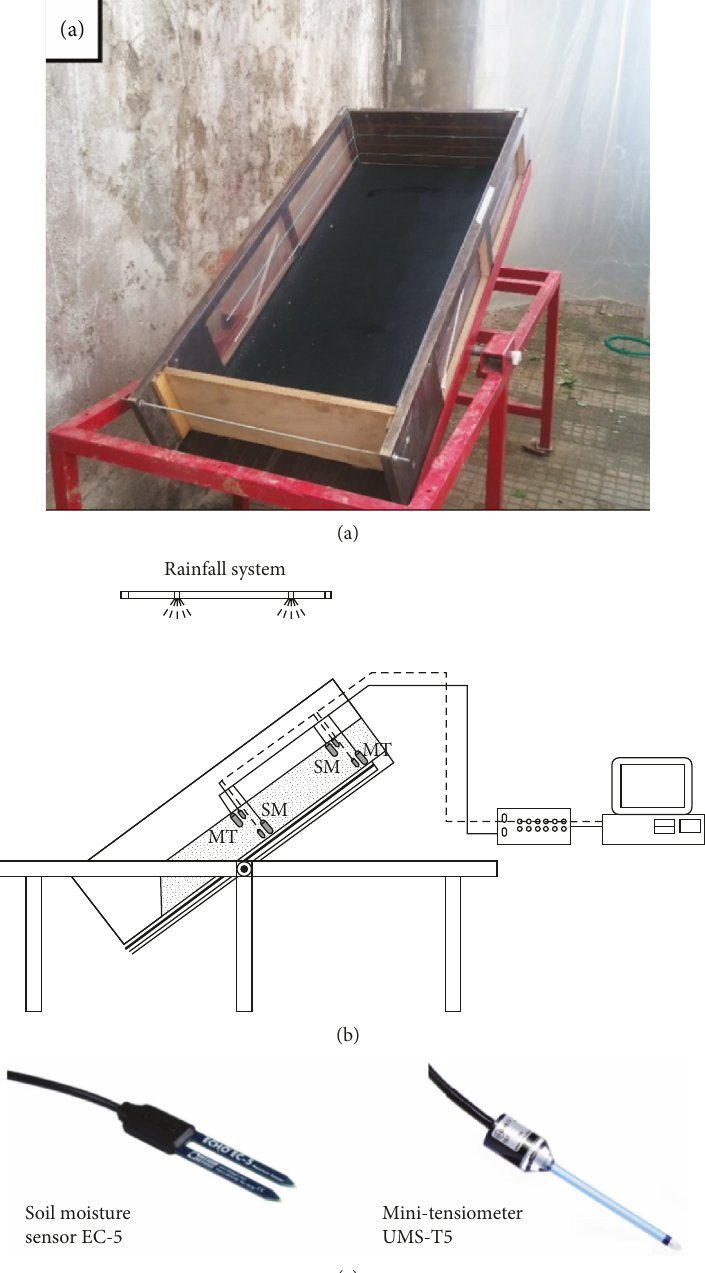
Figure 4: (a) The experimental fl ume; (b) scheme of the experimental apparatus (SM: soil moisture sensor; MT: mini-tensiometer); (c) sensors used for the monitoring of soil water content and pore water pressure during the